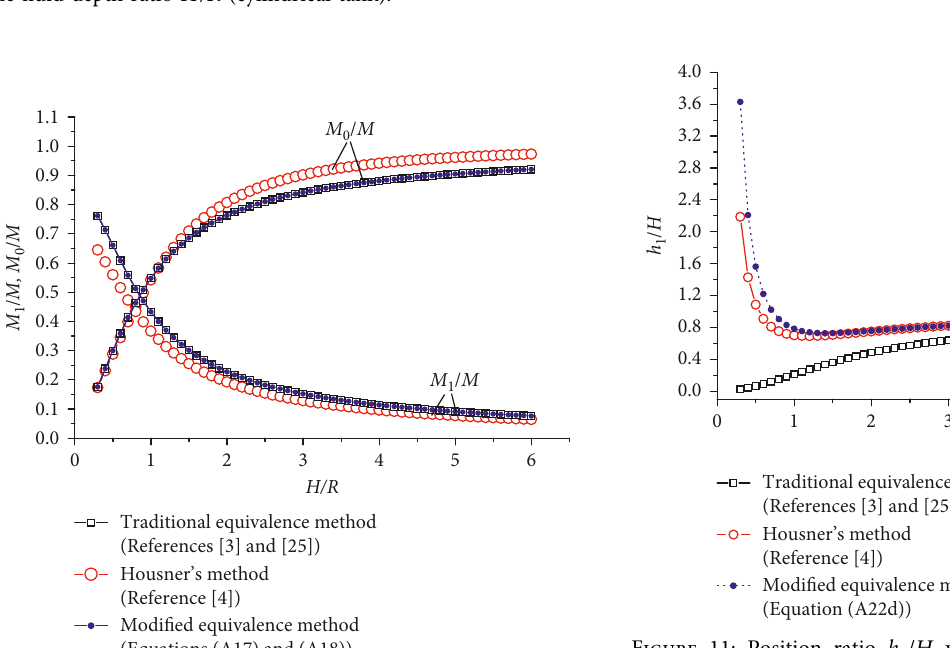
/ H vs. the fluid depth ratio H / R 1